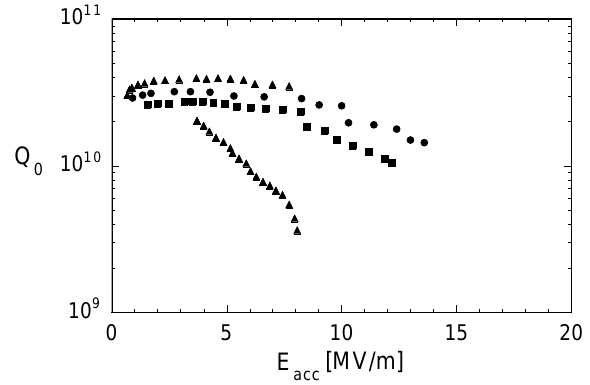
FIG. 15. Excitation curves of three cavities with serious mate- rial defects (class 2). Cavity C5 ( (cid:2) ) exhibited a jump in quality factor.